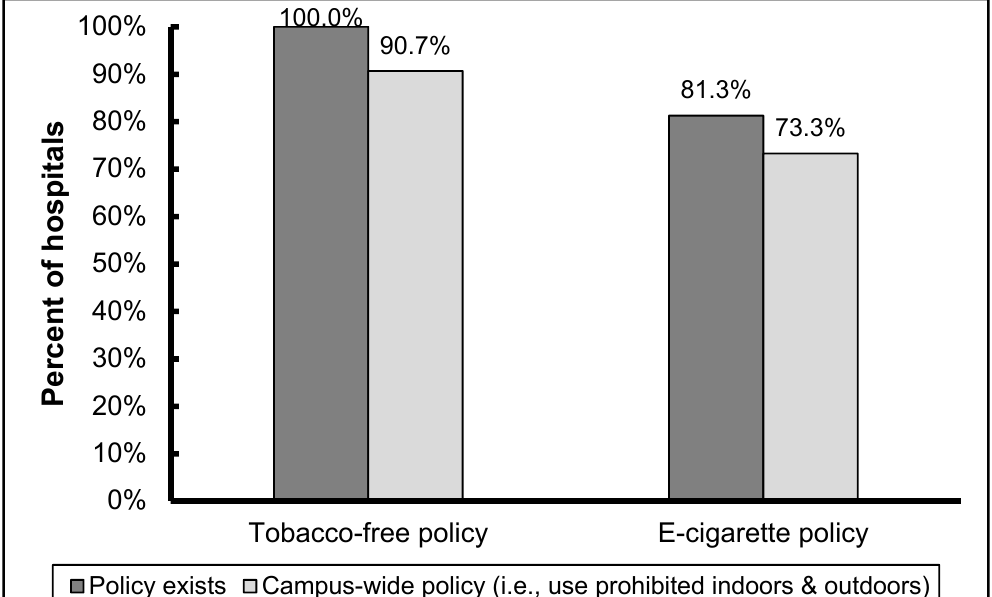
Figure 1. NC hospital campus tobacco policies ( n = 75).